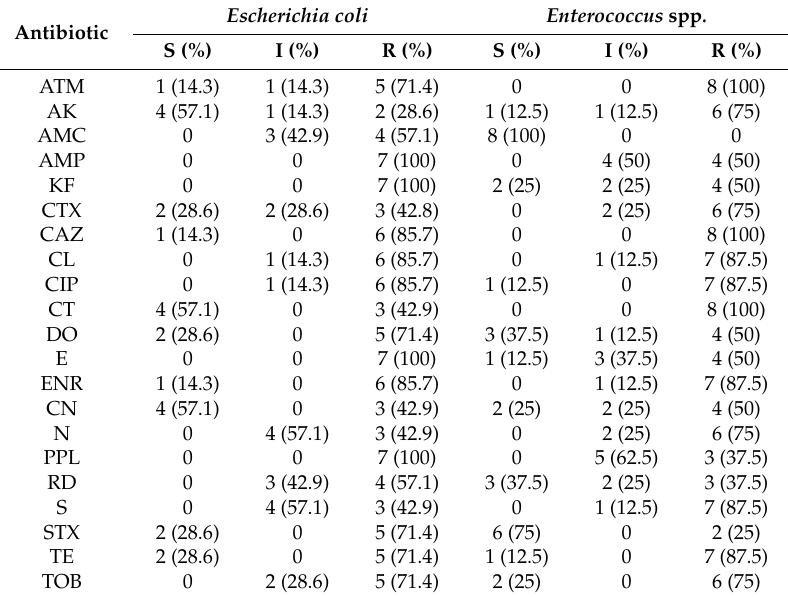
Table 3. Number and percentages of Escherichia coli and Enterococcus spp. isolates resulted sensitive, intermediate or resistant versus tested antibiotics. Escherichia coli Enterococcus spp Antibiotic